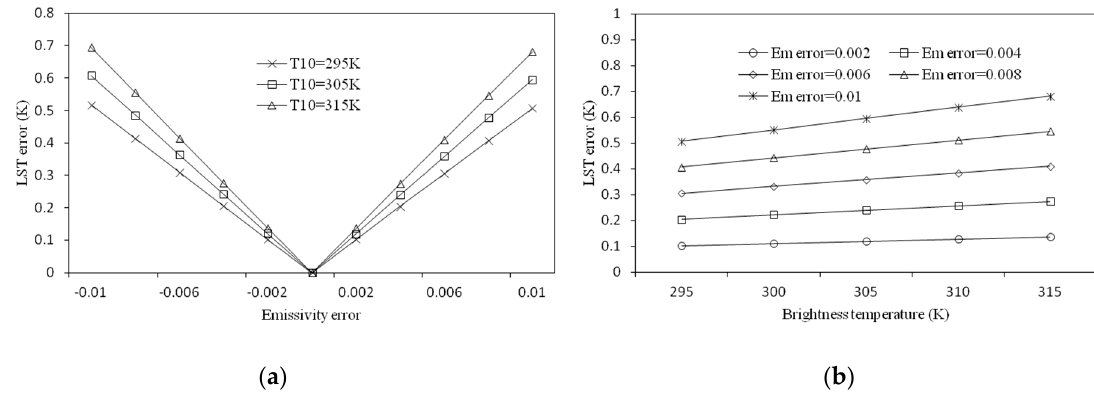
Figure 13. LST estimation error of the single-channel method as a result of the estimation error in LSE. ( a ) LST error against the emissivity error and ( b ) LST error against brightness temperature for different emissivity error.